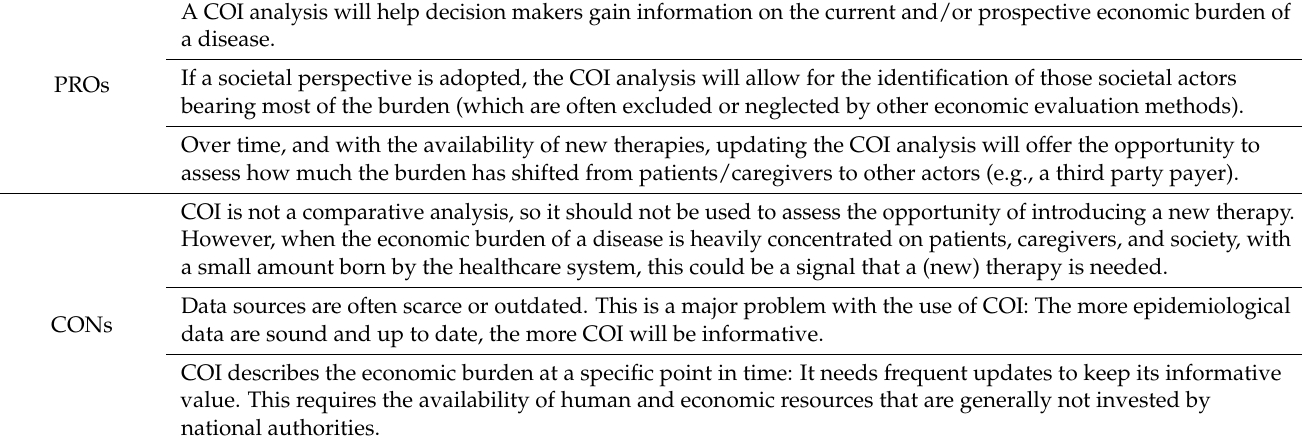
Table 3. “Pros” and “cons” of cost of illness (COI)